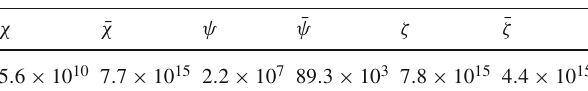
Table 4 Masses in GeV scale. M str = M GUT = 1 . 4 × 10 16 GeV